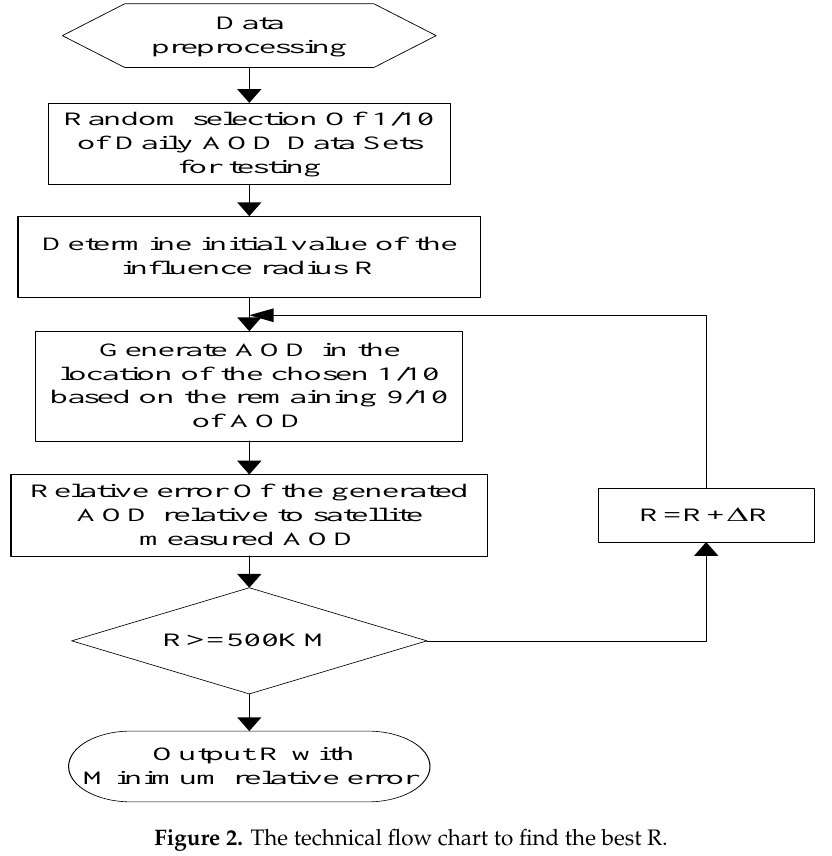
Figure 2. The technical flow chart to find the best R.